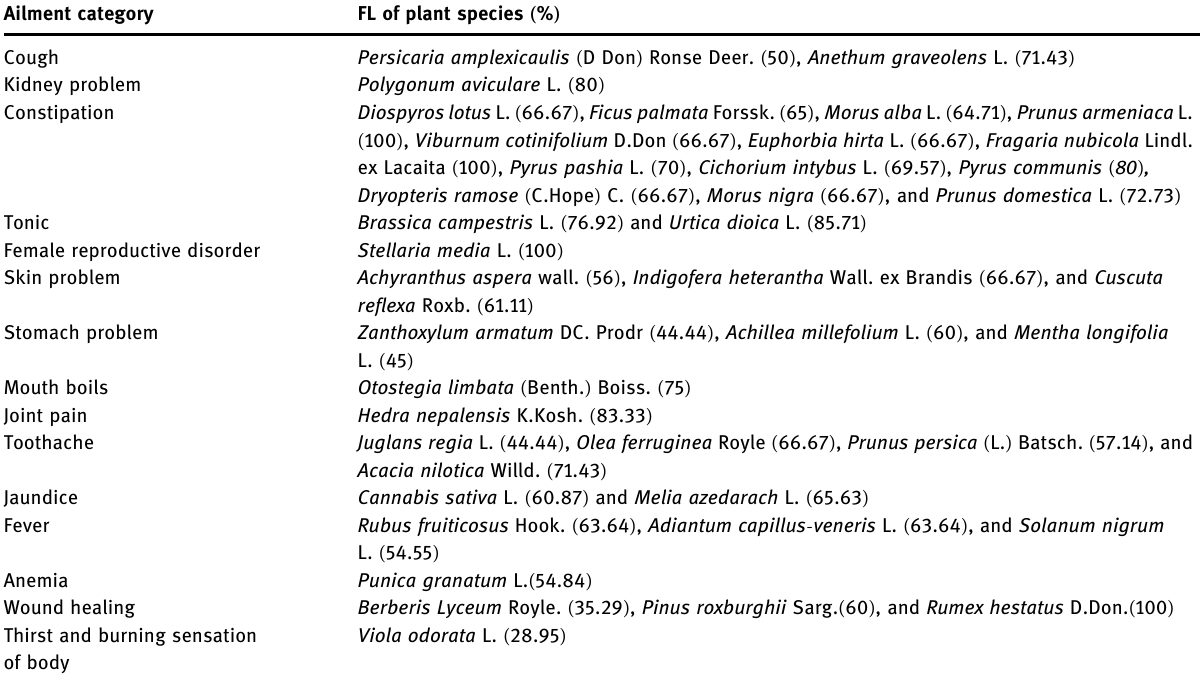
Table 2: FL of observed species from study area Ailment category